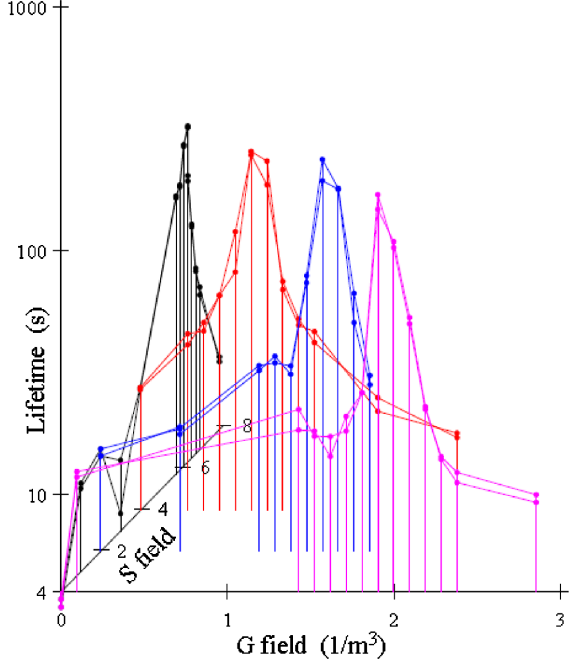
FIG. 12. Representations of the IPP lifetime τ on a projected graph as a function of S and G field values for the wide beam. The various scans are shown with different colors. Scan 1 is lavender, 2 is black, 3 is blue, and 4 is red. The two polarization states are plotted separately; their values overlap closely and show essen- tially the same